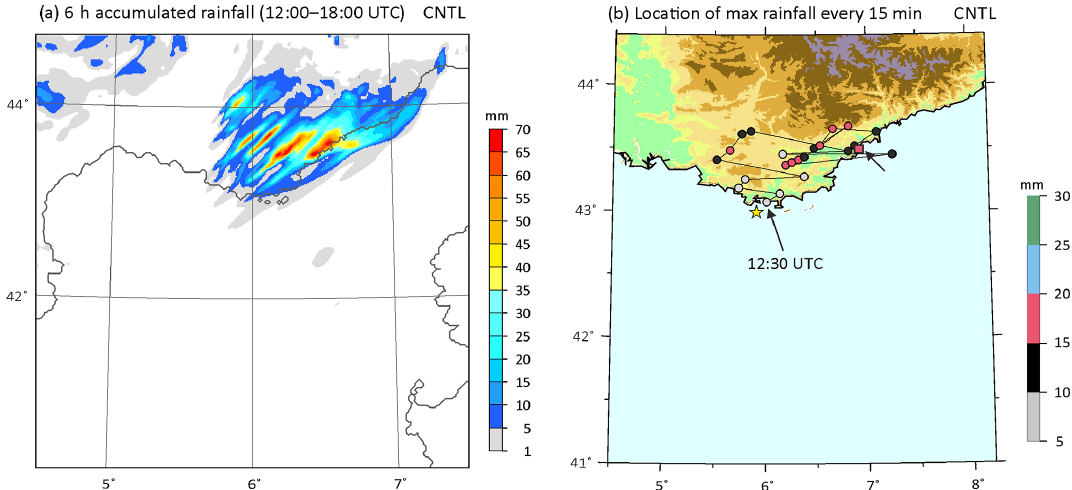
Figure 2. (a) The 6h accumulated precipitation at 18:00UTC and (b) evolution every 15min between 12:00 and 18:00UTC of the locations of maximum 15min accumulated rainfall amount (RR max ) simulated by the control run (CNTL) on 14 October 2012. Also shown is the topography (see Fig. 1 for the scale). The location of first convection initiation (reflectivity over 45dBZ) is marked by a yellow star, and the last precipitating point at 18:00UTC is marked by a square with an arrow pointing to it in panel (b) .